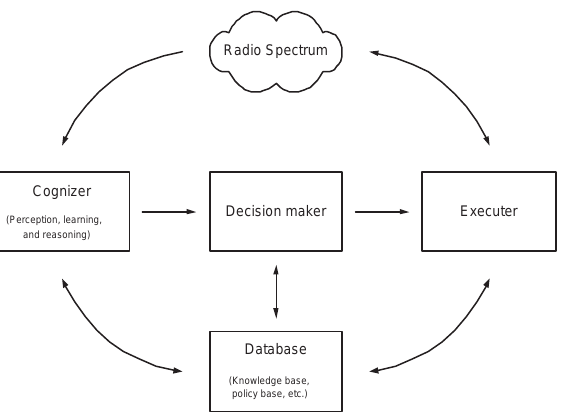
Figure 34. A unified framework for cognitive radio and cognitive